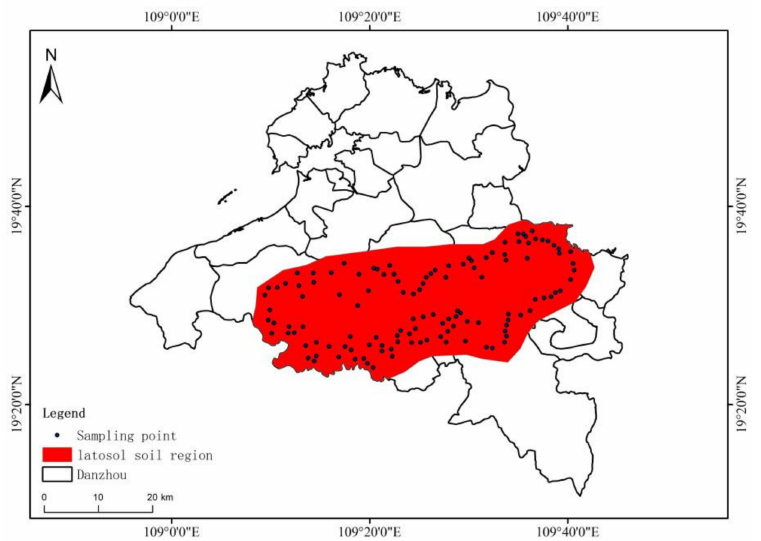
Figure 1. Location of the study area and the spatial pattern of soil sampling in Hainan province, Southern